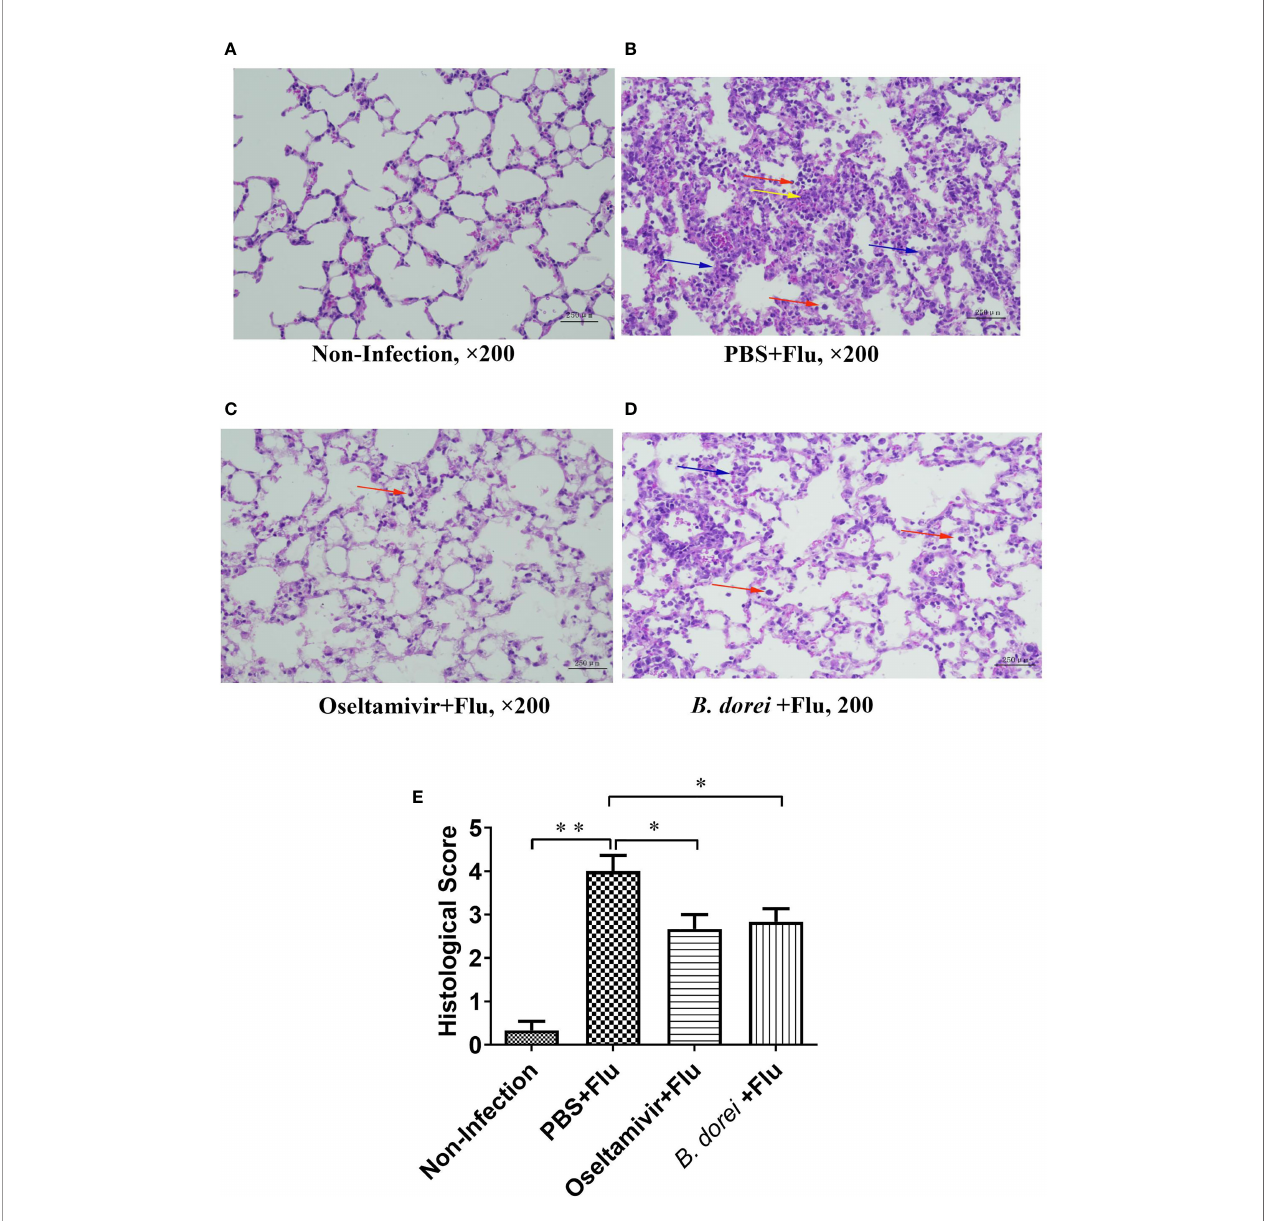
FIGURE 3 | Histopathological fi ndings of the lung of in fl uenza-infected mice successively receiving B. dorei or oseltamivir at 7 day post infection. Lung histopathological examination (HE staining, 200×) are shown in panel (A – D) . (A) the control group; (B) the PBS+Flu group; (C) the B. dorei +Flu group; (D) the oseltamivir+Flu group; (E) Histopathological scores of four groups. Representative results are obtained from three independent experiments. *p < 0.05, **p < 0.01. In fl ammatory cell in fi ltration (red arrows), alveolar wall thickening (blue arrows) and microvascular congestion and hemorrhage (yellow